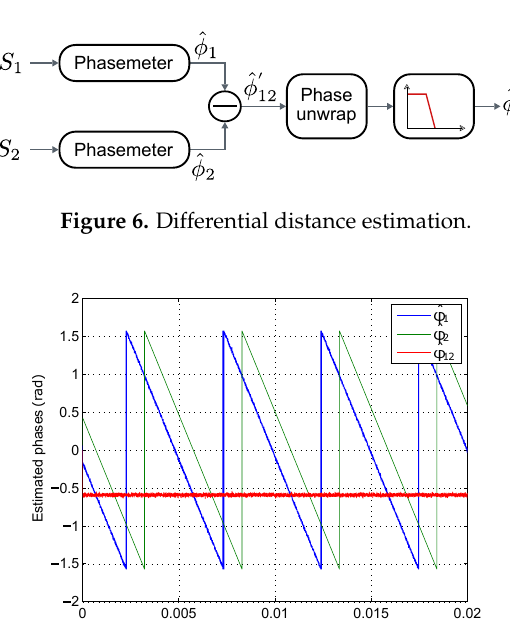
Figure 5. Phasemeter.